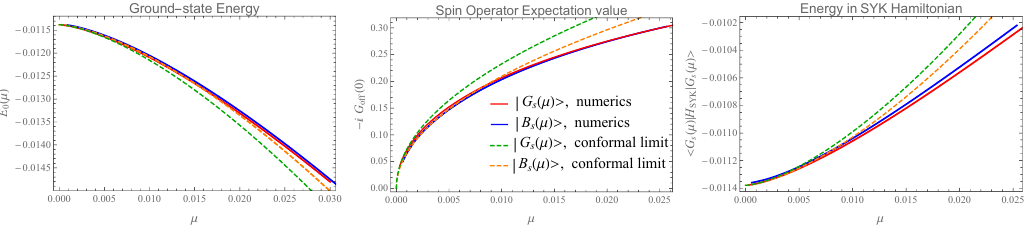
Figure 7 . Comparing the (cid:22) dependence T ( (cid:22) ) = (cid:12) ( (cid:22) ) approximation and exact numerical calculation for q = 4 and q = 6 case. The conformal limit is given by (3.41).